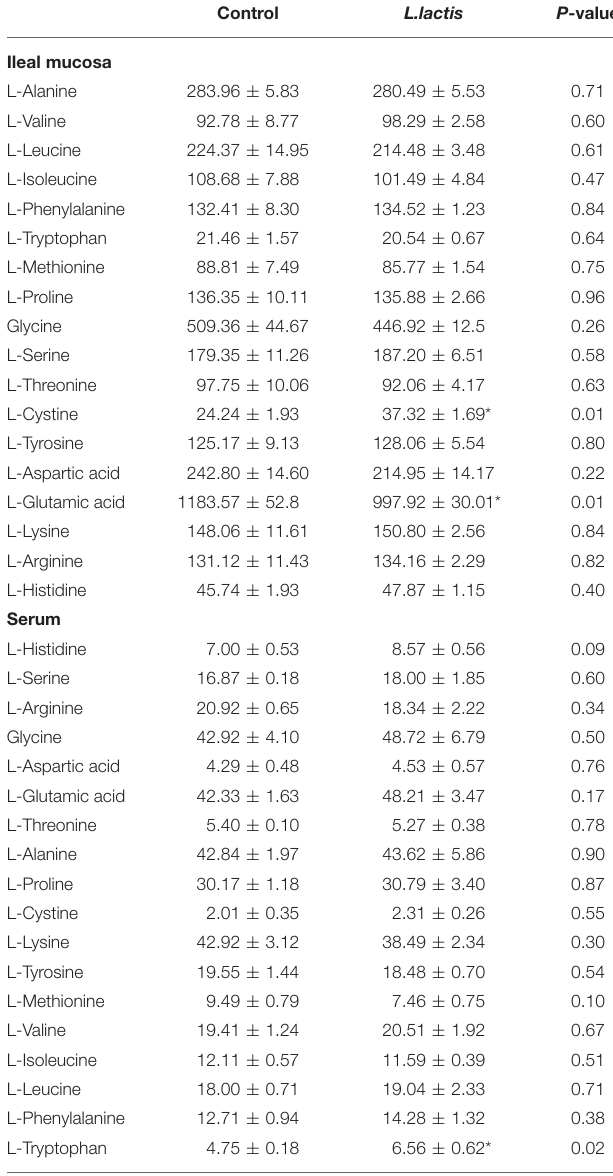
Amino acid profiles of the ileal mucosa and serum were detected by HPLC. Piglets from control group (n = 7) and L.lactis group (n = 8). Unpaired t-test was used to analyze data (mean ± SEM). * P < 0.05.